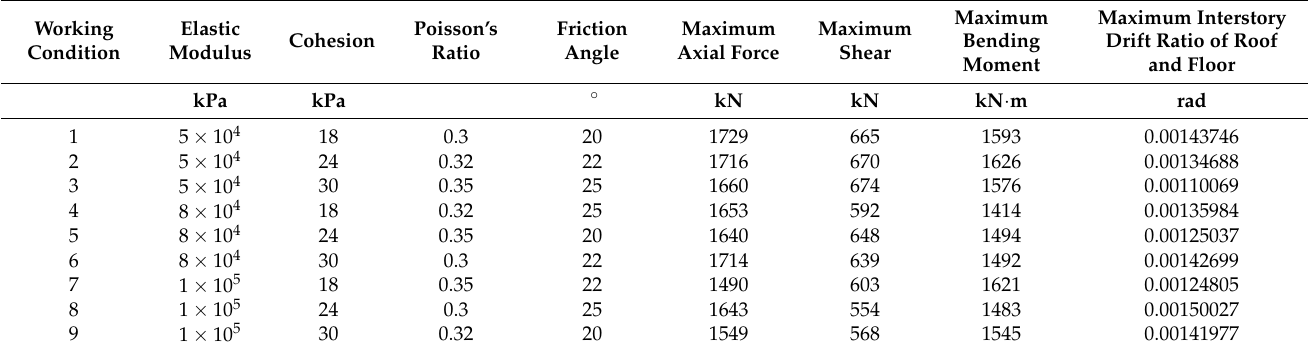
Table 5. Dynamic response values under horizontal and vertical